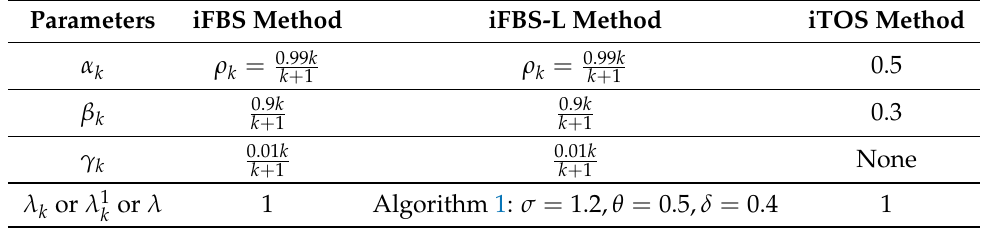
Table 1. Details of parameters for each